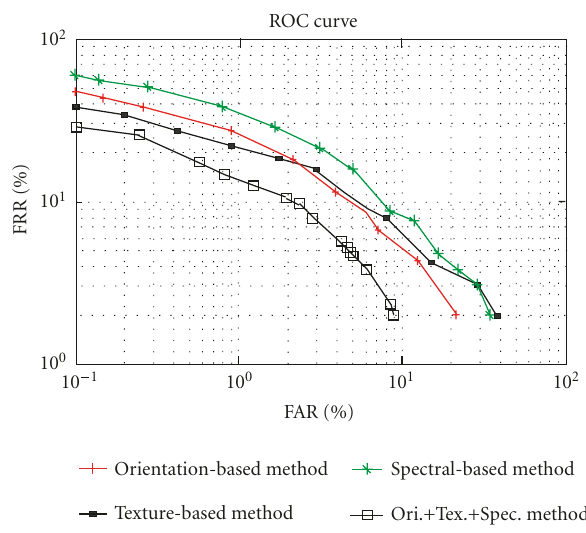
Figure 7: ROC curve for three proposed verification method and decision-level fusion of them.